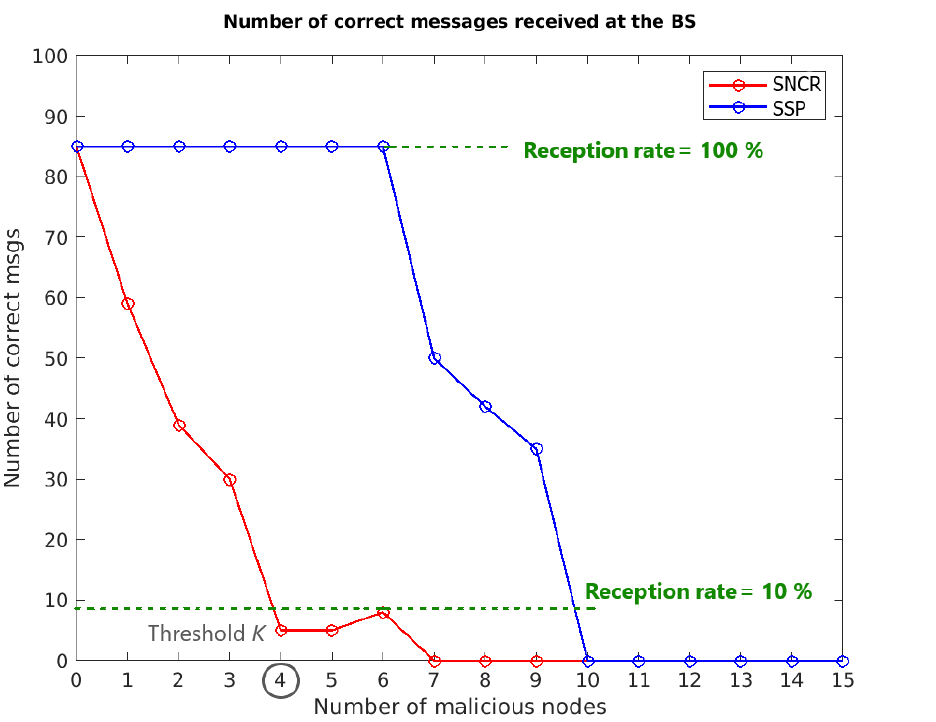
Figure 8. Number of correct messages for SSP